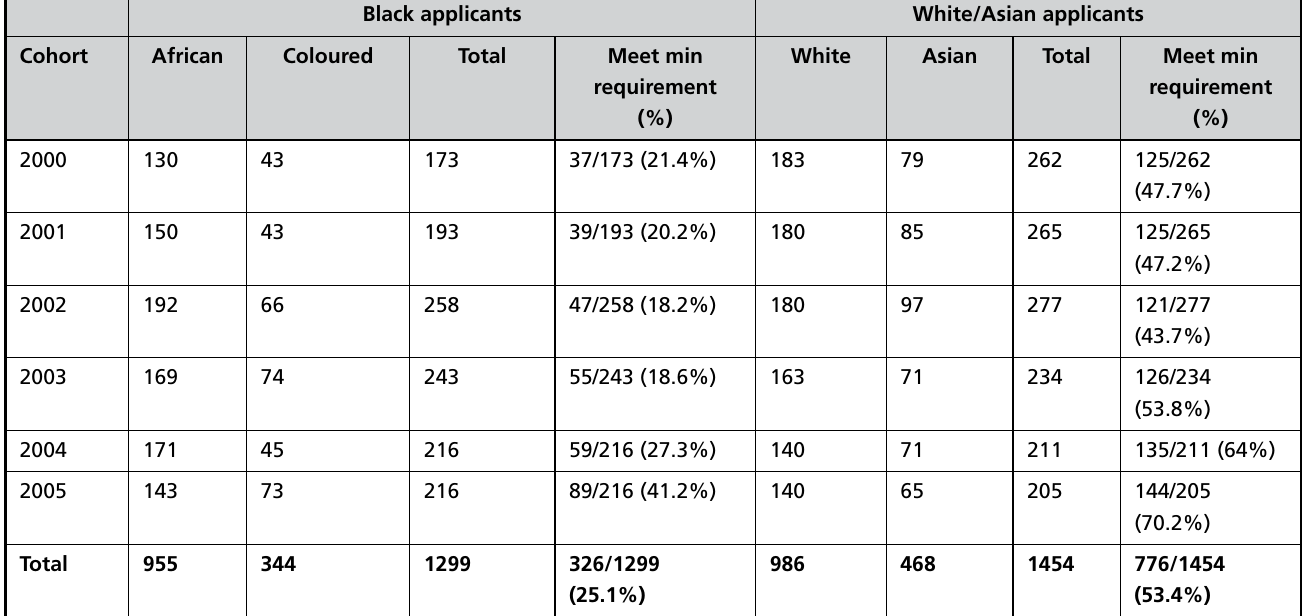
Table 2: Racial profile of applicants meeting minimum admission requirements among six cohorts of applicants (years 2000 to 2005)